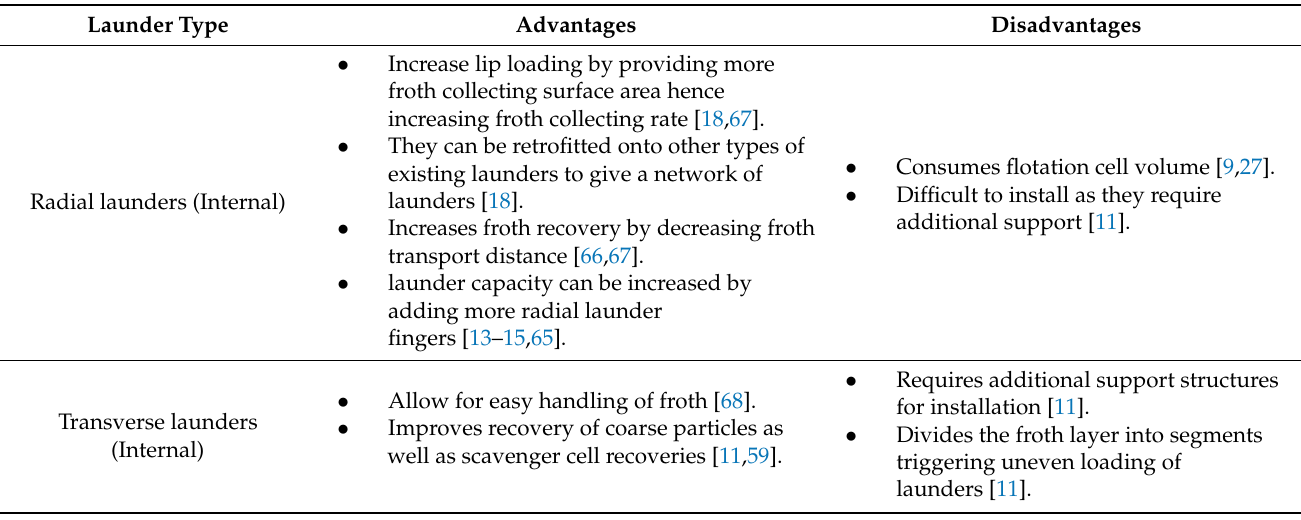
Table 3. Advantages and disadvantages of various launder